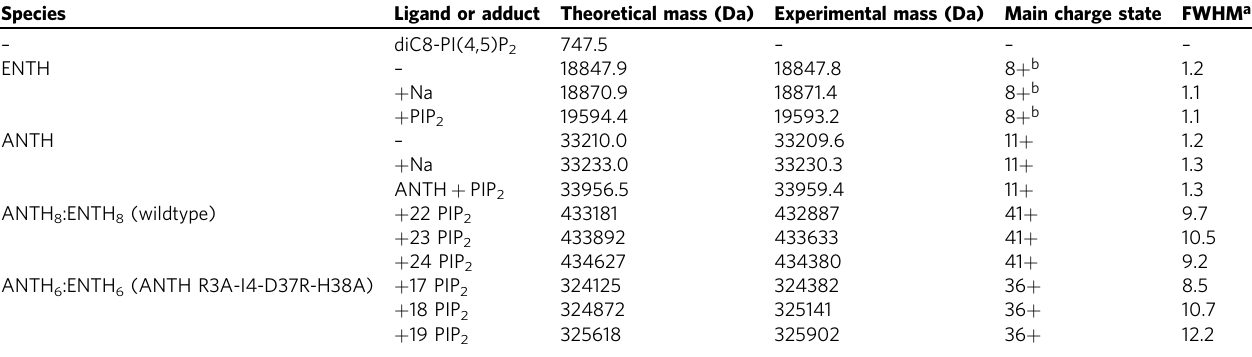
Table 1 Experimental and theoretical masses for ANTH, ENTH, PIP 2 , and adducts/complexes observed by native MS.